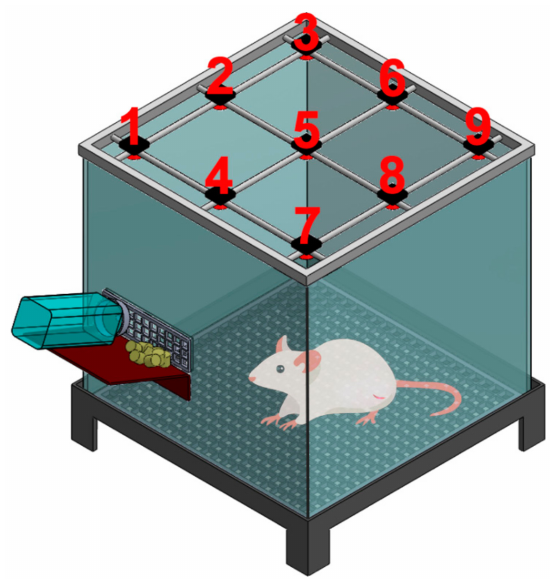
Figure 9. Schematic representation of the animal activity